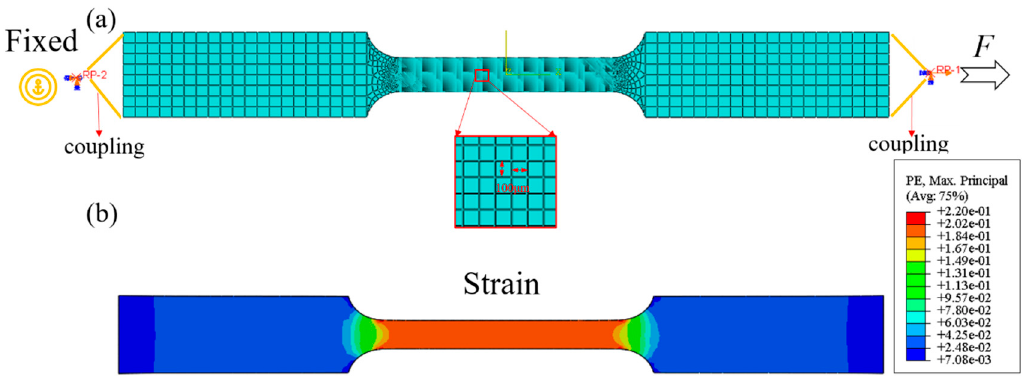
Figure 2. ( a ) Finite element model of the uniaxial tension test ( b ) Strain distribution.